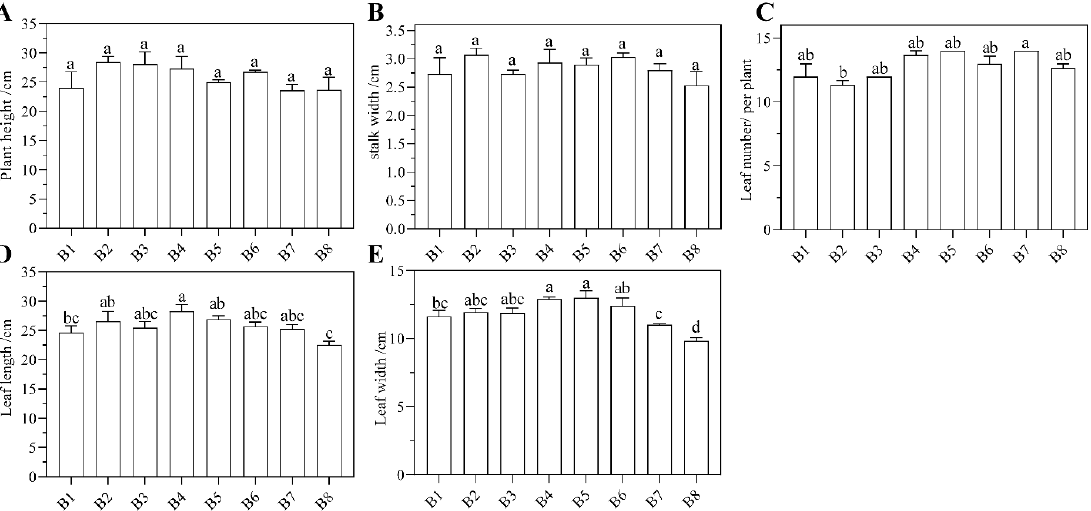
Figure 2. Characteristics of agronomic parameters of flue-cured tobacco under different B concentrations. Note: tobacco characteristics of agronomic parameters of flue-cured tobacco under different B concentrations. ( A ) Plant heights. ( B ) Stalk width. ( C ) Leaf number. ( D ) Leaf length. ( E ) Leaf width. Data are means ± standard errors ( n = 3). Within a column, values followed by different lower letters are significantly different at p < 0.05 following Duncan’s multiple-range test.